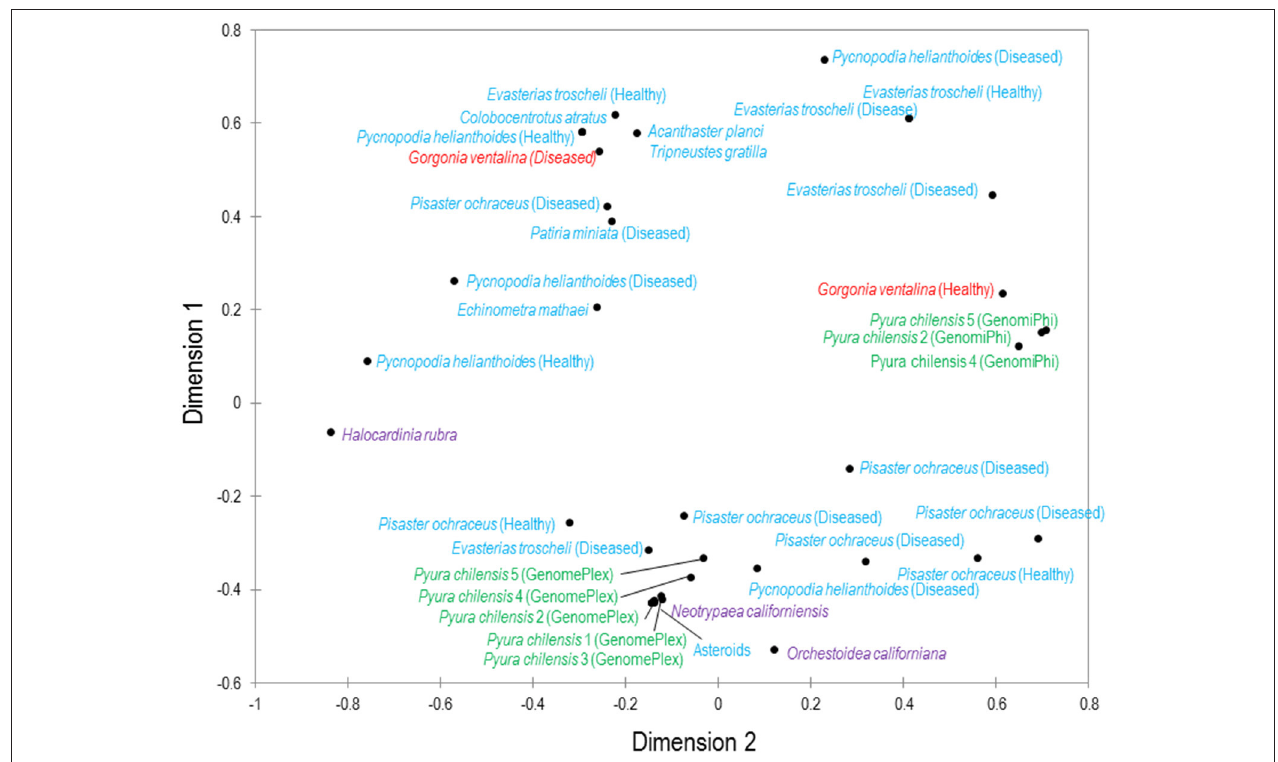
FIGURE 2 | Multiple dimensional scaling plot of viral metagenomes prepared from four phyla. MDS plot represents two-dimensional scaling analysis (absolute model, Kruskal’s stress, random initial configuration, five repetitions, stop condition at 0.00001 convergence/500 iterations). The phyla are color-coded: blue are echinoderms, red are gorgonian octocorals, green are urochordates and purple are crustaceans. Bacteriophage and unclassified viruses are not included in this